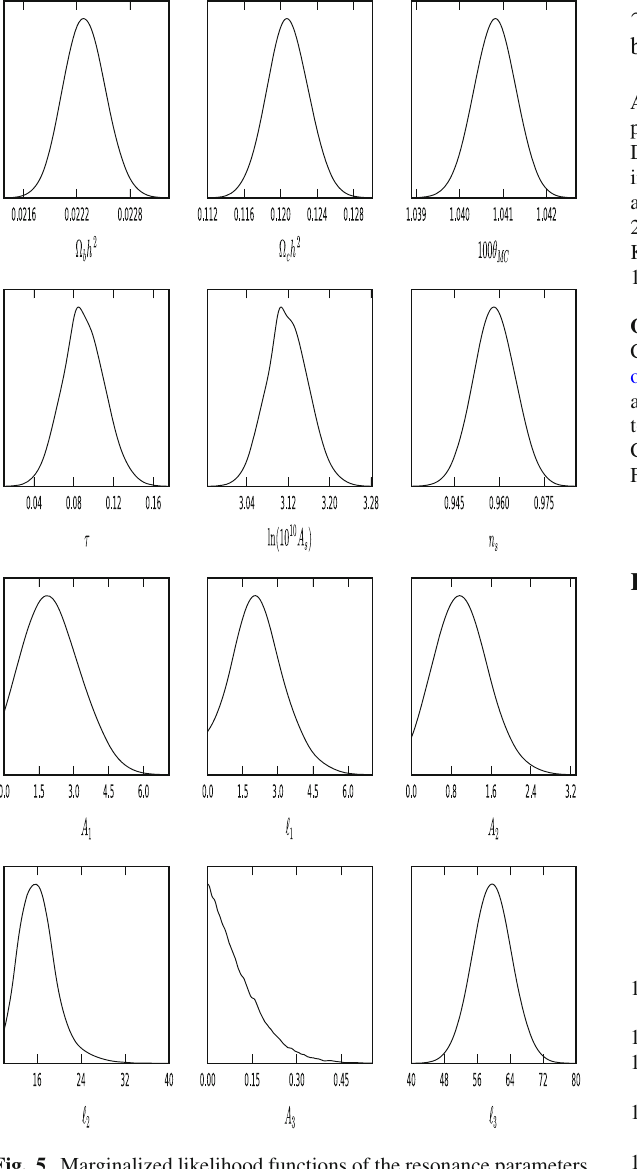
Fig. 5 Marginalized likelihood functions of the resonance parameters and some cosmological observables as labeled. The resonance param- eters are the same as in Fig.